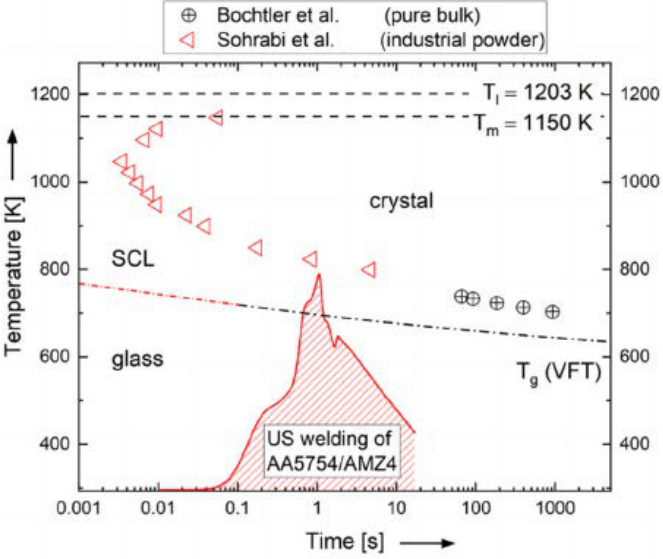
Figure 8. Isothermal time–temperature–transformation (TTT) diagram of AMZ4, based on [28,40–42]. The dashed lines correspond to the solidus temperature, T m , and the liquidus temperature, T l , which are both fixed temperatures upon heating (time-independent). The dashed–dotted line represents the time for the glass transition temperature T g , at a given temperature. It is approximately the structural relaxation time at a given temperature and therefore increases with decreasing temperature. Its temperature dependence can be well expressed with a Vogel–Fulcher–Tammann equation (VFT) [46]. The crystallization times at a given temperature are represented by red triangles (Sohrabi et al.) [40] and crossed circles (Bochtler et al.) [42]. The experimentally detected temperature profile of the ultrasonic (US) welding process is plotted as a red solid line and it does not reach the TTT for crystallization of AMZ4, rather it only reaches for a short time the supercooled liquid (SCL).